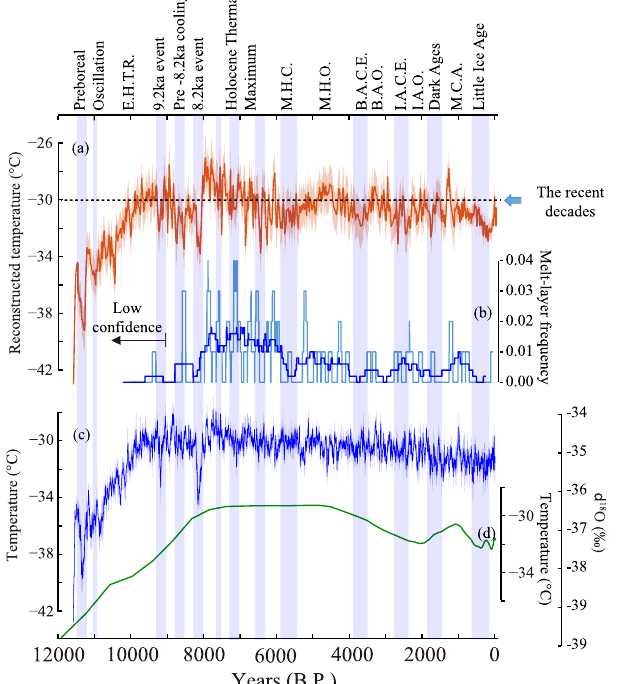
Figure 2. Greenland Summit temperature and its proxies over the Holocene. ( a ) Reconstructed temperature from argon and nitrogen isotopes with 2 σ error bands. ( b ) Melt-layer frequency (times per years) in 100 and 500-year RMs with light blue and blue lines, respectively. Note that the data before 9000 B.P. has low confidence 20 . ( c ) δ 18 O ice and a calibrated temperature scale in 20-year RMs with 2 σ error bands from GISP2 14 , GRIP, and NGRIP 15 (Methods) ( d ) GRIP borehole temperature inversion 42 . Blue shades are Greenland